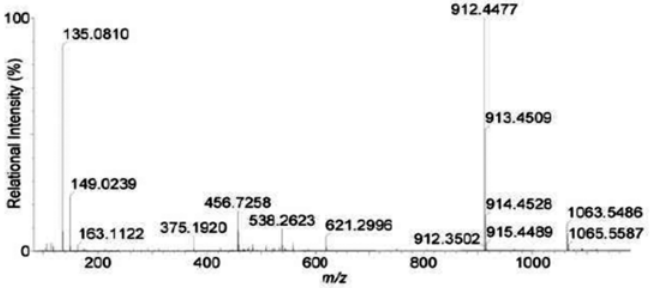
Fig 5. Liquid chromatogram-mass spectrum (LC-MS) profile of product A.